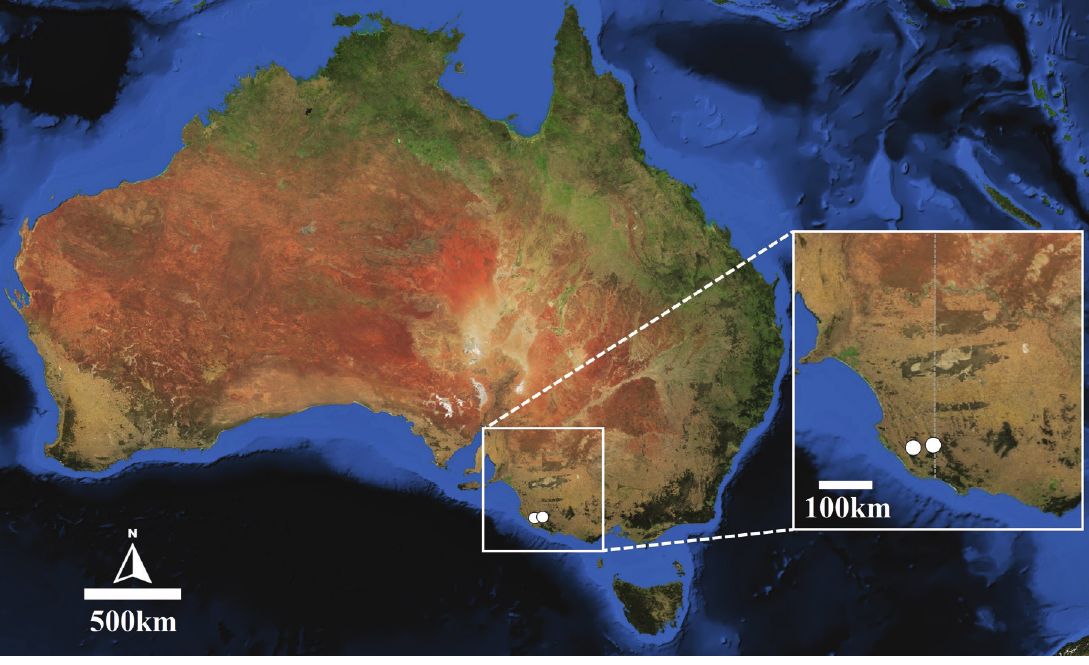
Figure 9. Localities Maratus nemo sp. nov. is known from in Southern Australia (9.5km SSE of Mount McIntyre, 9.4km SSE of Mount McIntyre, and 14.1km E of